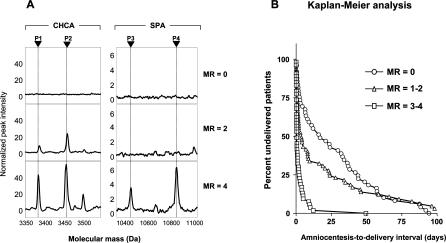
Proteomic Profiling of AF and Risk for Preterm Delivery(A) Representative SELDI-TOF mass spectrometry profiles of the AF based on the “severity” of inflammation (MR = 0 indicates “no” inflammation; MR = 2 indicates “minimal” inflammation; and MR = 3–4 indicates “severe” inflammation). Five microliters of diluted AF (1:10) was placed in duplicate on spots of H4 ProteinChip arrays (Ciphergen Biosystems, Fremont, California, United States) and incubated for 1 h. After 1 h, the AF samples were aspirated, and the spots were individually washed three times with 25% acetonitrile solution, air dried, and then overlaid with matrix solution (1 μl of 20% saturated solution of α-cyano-4 hydroxycinnamic acid [CHCA] on one array and two overlays of 1 μl of 50% saturated solution of sinnapinic acid [SPA] on the other array). The chips were air dried and then read in a Protein Biology System IIC (PBS IIC) SELDI-TOF mass spectrometer (Ciphergen Biosystems) using the ProteinChip software v3.1.1. The CHCA chip allows for the identification of defensins 2 (P1: 3,377.01 Da) and 1 (P2: 3,448.09 Da). The SPA chip allows for identification of the peaks corresponding to calgranulin C (P3: 10,443.85 Da) and calgranulin A (P4: 10,834.51 Da). The x-axis of the tracings represents the molecular mass in Daltons; the y-axis represents the relative peak intensity.(B) Cumulative probability of pregnancy maintenance for the 169 patients illustrating the duration from amniocentesis to delivery in women with MR scores of 0 (zero), MR scores of 1–2, and MR scores 3–4.